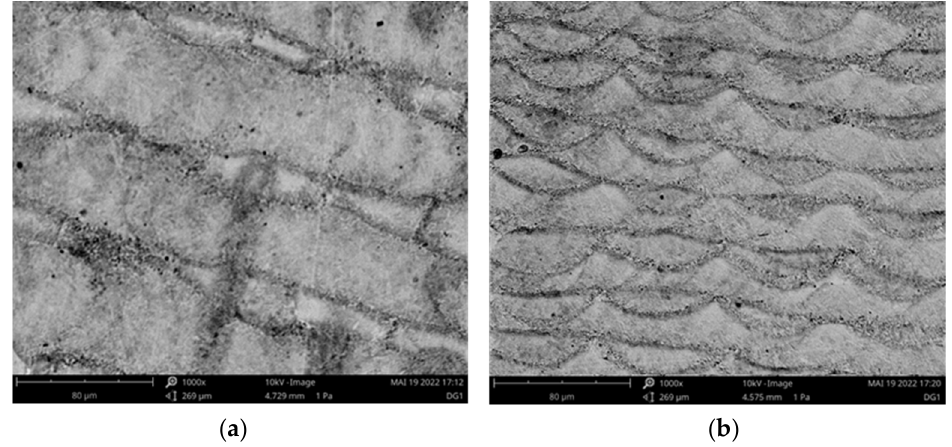
Figure 8. SEM images of the metallographically prepared ( a ) transverse and ( b ) longitudinal cross- sections of a manufactured sample. sections of a manufactured sample.